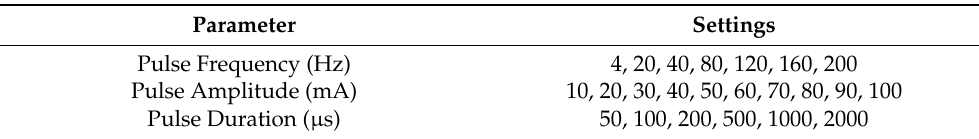
Table 1. Parameters used to test the SEQ adapter. Every combination of parameters was tested in individual trials, for a total of 420 trials.